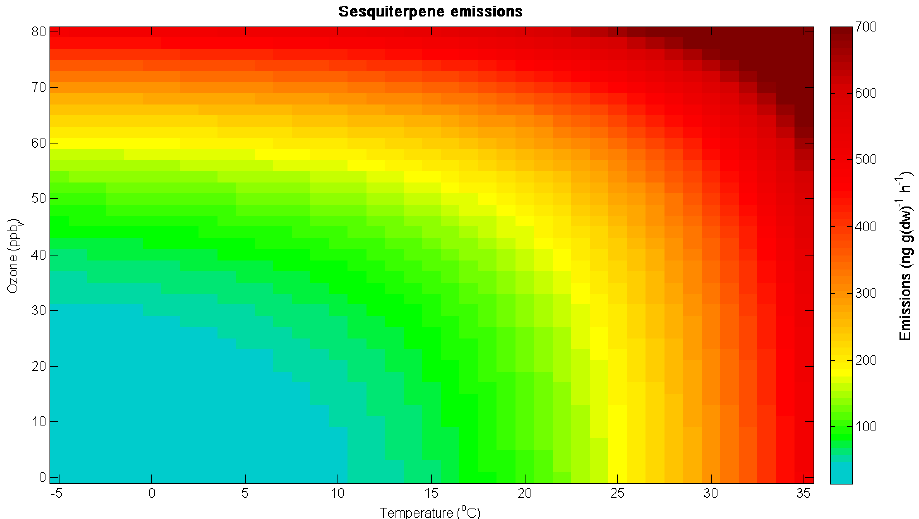
Fig. 6. Pattern of the derived SQT emissions, parameterised for the site of